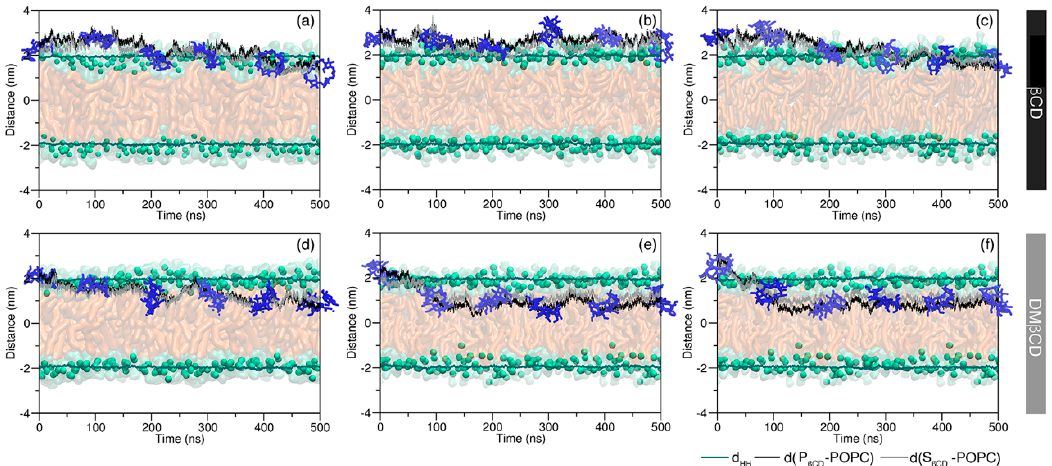
Figure 2. Time evolution of the distance between the centers of mass of the lipid bilayer (z = 0) and each rim of ( a – c ) β CD and ( d – f ) DM β CD. The distance between phosphate groups of each membrane leaflet (d HH ) and the center of membrane is represented by a green line, while the distances of the primary and secondary rims of β CDs, d(P β CD -POPC), and d(S β CD -POPC), relative to the lipid bilayer are represented by black and grey lines, respectively. The MD snapshots of β CDs along the simulation time are also given in the presence of the membrane